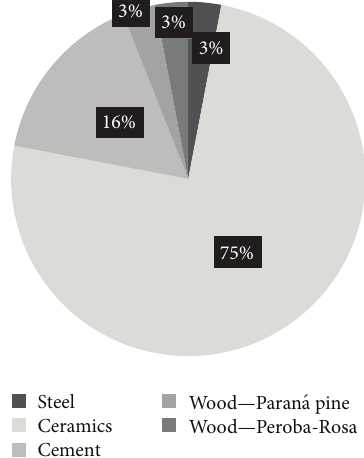
Figure 7: Composition of building materials (kg)